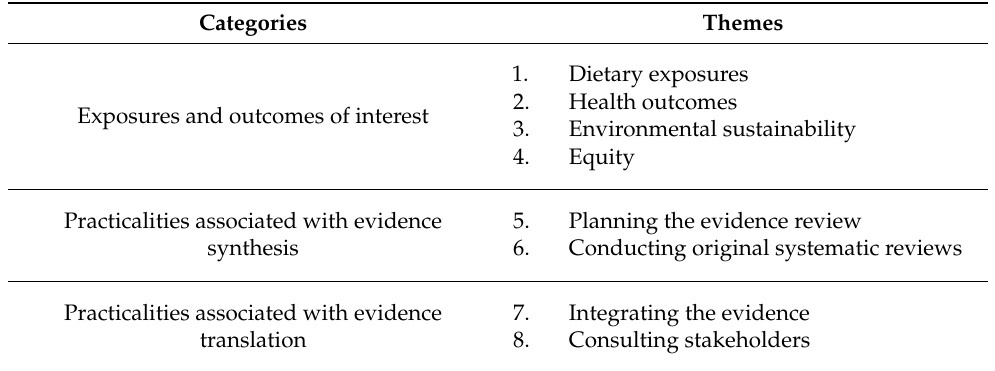
Table 1. Overview of the eight themes that emerged from the data, organised under three